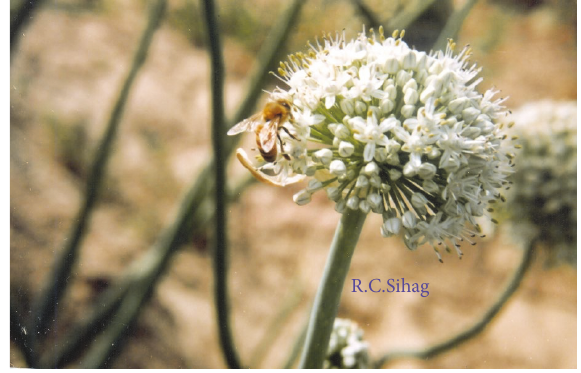
Figure 5: A forager of the European honeybee ( Apis mellifera L.) collecting nectar as well as pollen from the top/front of the flower of onion ( Allium cepa L.).